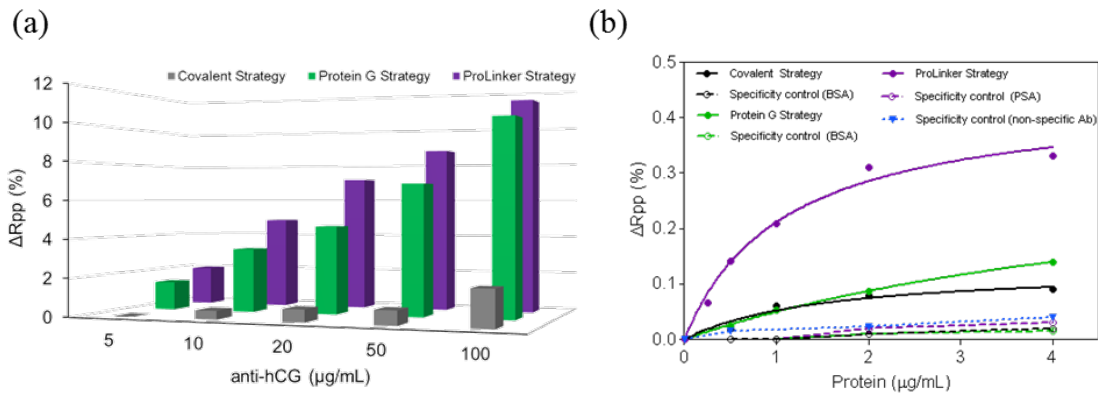
Figure 2. ( a ) Comparison of antibody immobilizations at different antibody concentrations (5, 10, 20, 50, 100 µg/mL) with different strategies. Grey: covalent strategy; Green: Protein G strategy ([Protein G] = 50 μg/mL); Purple: ProLinker™ strategy; ( b ) Antigen detection performed with hCG/anti-hCG for covalent strategy (black), Protein G strategy (green) and ProLinker™ strategy (purple). Concentration of anti-hCG antibody was 10 µg/mL in all cases. Dashed lines represent adsorption of nonspecific proteins onto antibody functionalized surfaces for covalent strategy (black), Protein G strategy (green) and ProLinker™ strategy (purple). Blue dotted line indicates additional control for the ProLinker™ strategy, based on the detection of hCG onto a nonspecific antibody (10 µg/mL) immobilized over ProLinker™ layer (same experimental conditions as with specific